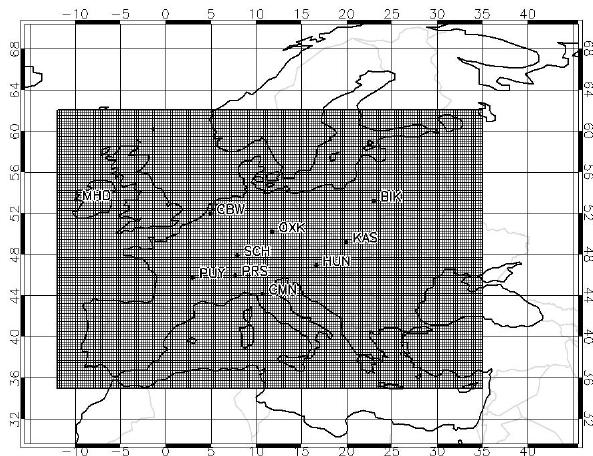
Fig. 1. The global and the regional